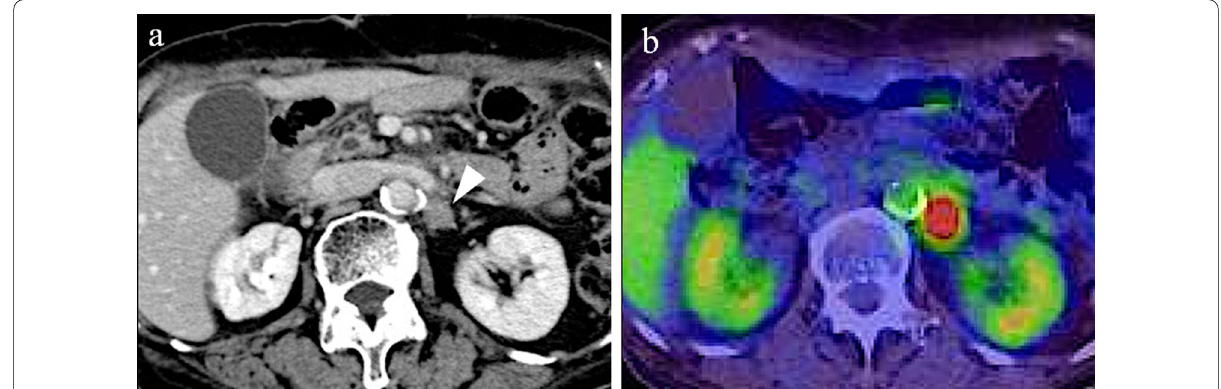
Fig. 3 a Contrast-enhanced CT and b fluorodeoxyglucose-positron emission tomography/CT at recurrence of cancer appeared in No. 16b1. The size was 14.6